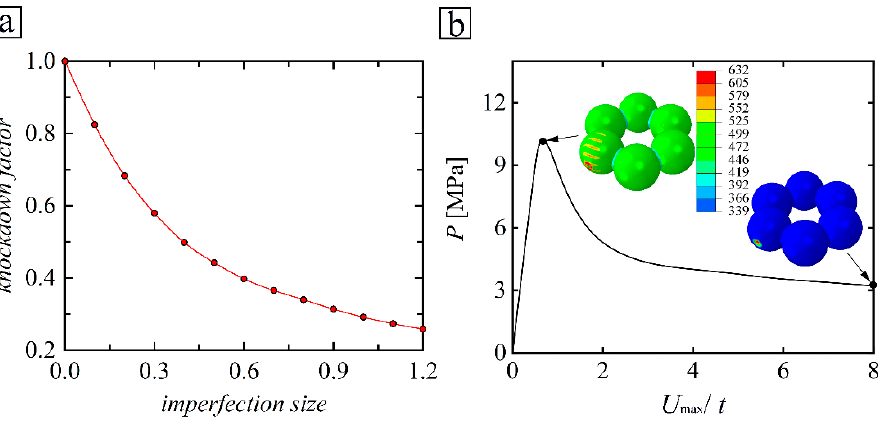
Figure 12. Imperfection sensitivities ( a ) and equilibrium path ( b ) of sphere-segmented toroidal shell.